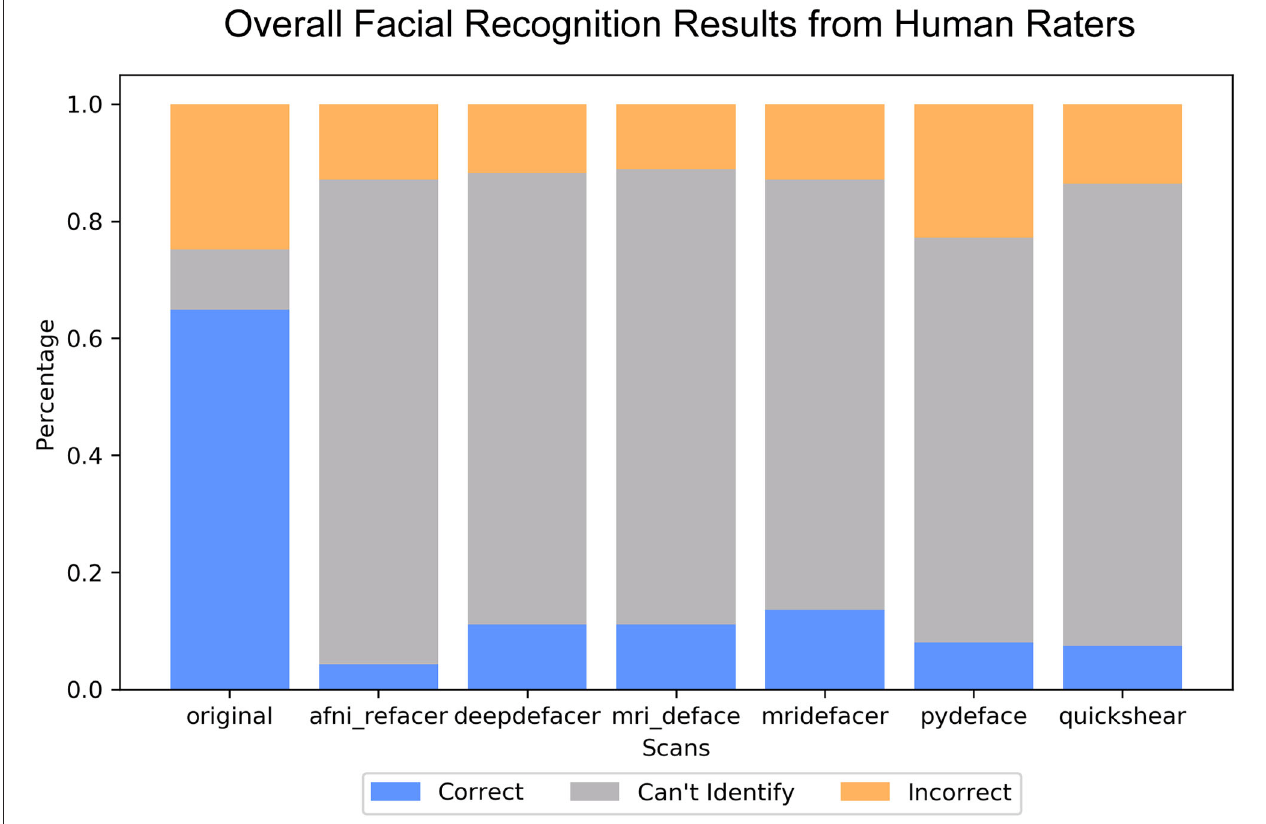
FIGURE 6 | Bar plot indicating the percent distribution of facial recognition quiz results across the nine raters, for the renders of the defaced and original scans. Renders that were correctly matched to their corresponding photograph are considered “correct,” renders that were matched to the wrong photograph are considered “incorrect,” and those that the raters felt were not clear enough to attempt an identification are labeled “can’t